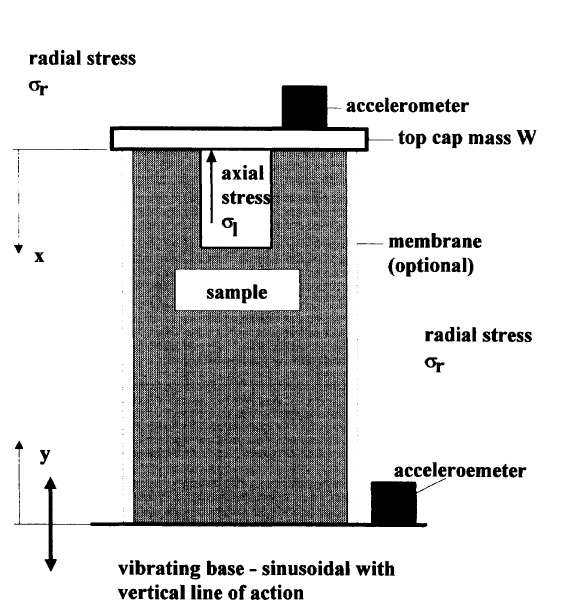
FIGURE 1 Experimental equipment: a triaxial speci men subject to uniaxial